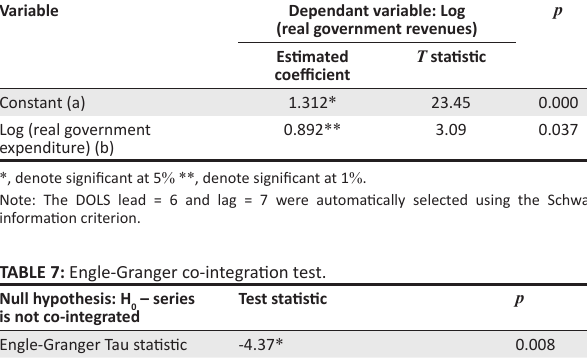
TABLE 6: Dynamic ordinary least squares estimation. Variable